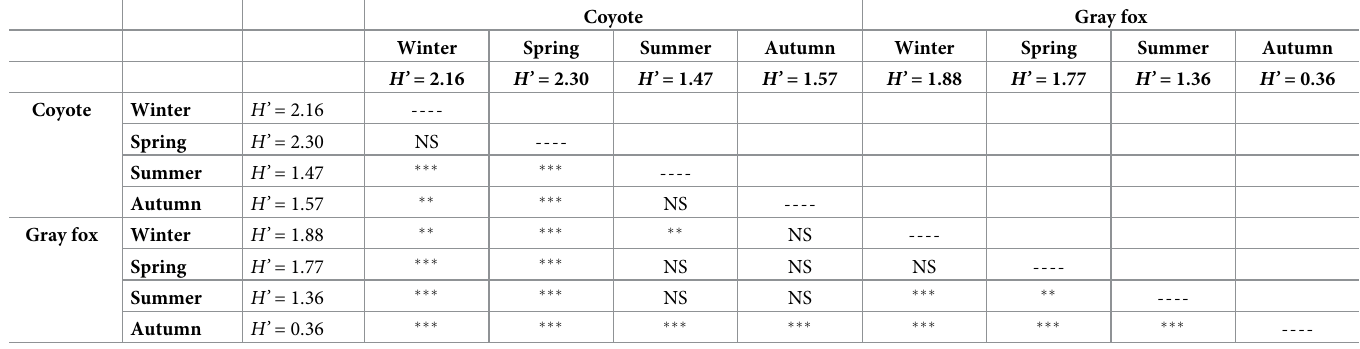
Table 3. Seasonal trophic diversity of coyotes and gray foxes, and significance values of Hutcheson’s t test between seasons, in the buffer zone of La Michilı´a Bio- sphere Reserve (MBR), Durango, Mexico.